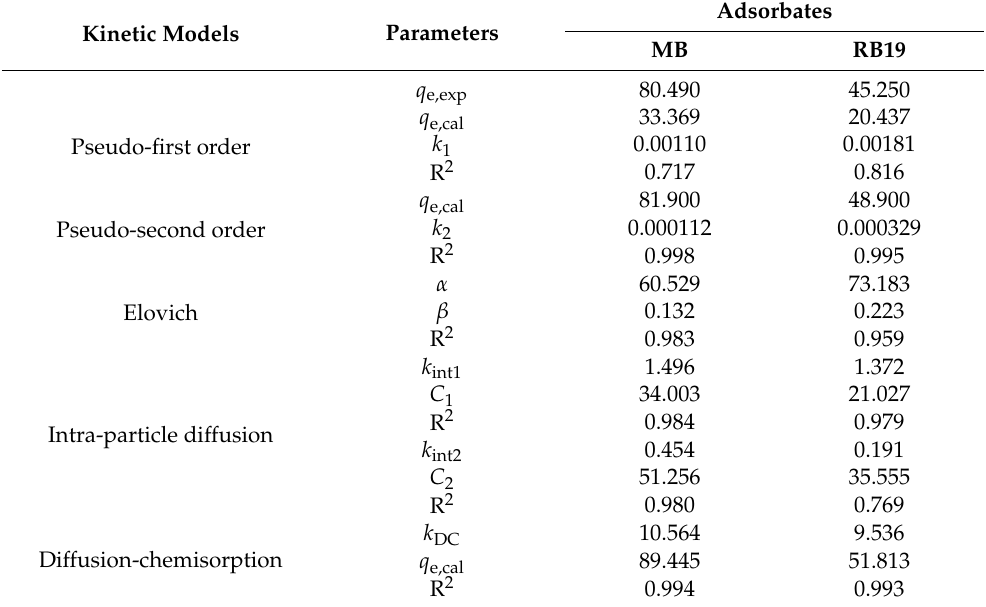
Table 1. Parameters of kinetic models for the adsorption of MB and RB19 onto